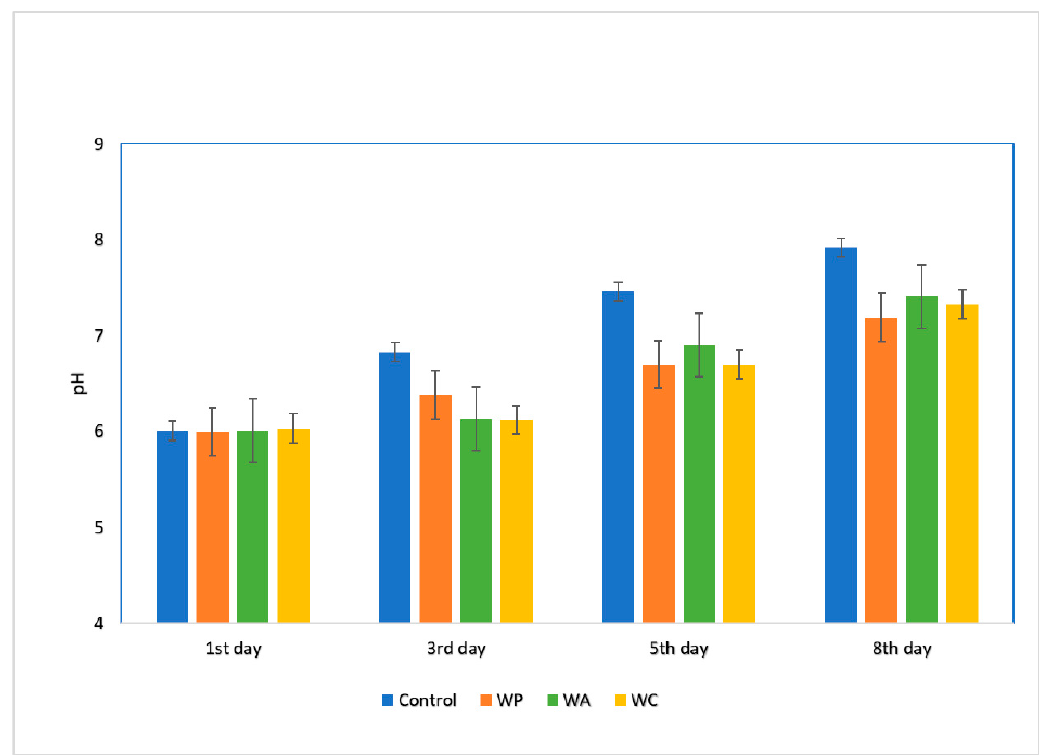
Figure 3. pH values during the period of refrigerated storage from the control and meatball samples with fruit extracts. Similar letters above bars indicate no significant interday differences (ANOVA, Tukey HSD) for each group of samples (control, WP: with aqueous pomegranate extract, WC: with aqueous cranberry extract, WC: with aqueous black chokeberry extract).